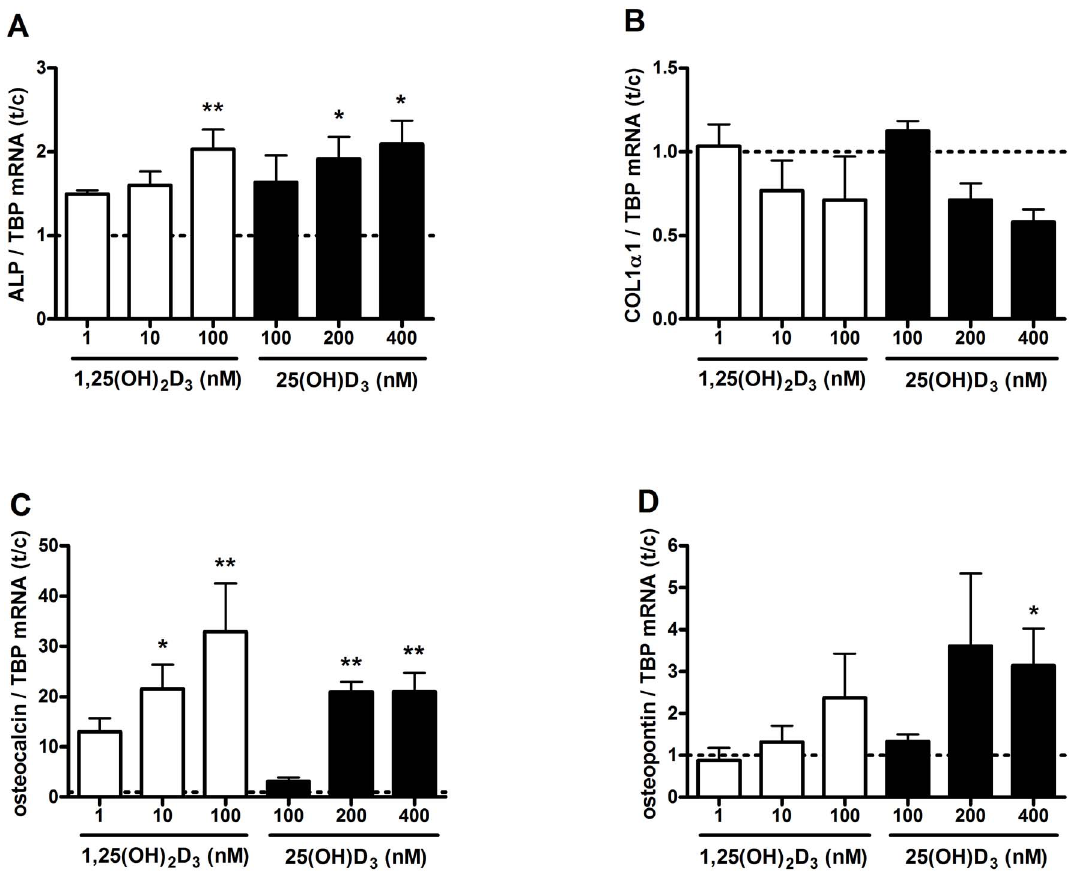
Figure 3. Effects of 1,25(OH) 2 D 3 and 25(OH)D 3 on mRNA levels of genes involved in primary human osteoblast differentiation. Osteoblasts were cultured in the presence of 0, 1, 10 and 100 nM 1,25(OH) 2 D 3 or 0, 100, 200 or 400 nM 25(OH)D 3 for 10 days in osteogenic medium and mRNA levels of ALP ( A ), COL1 a 1 ( B ), osteocalcin ( C ) and osteopontin ( D ) were determined. Results (mean 6 SEM) are expressed as treatment versus control ratios (control was set at 1.0; dashed line) using cells from 5 different donors. Results were analysed using Friedman test followed by Dunn’s post hoc test (*p , 0.05, **p , 0.01, ***p , 0.001).